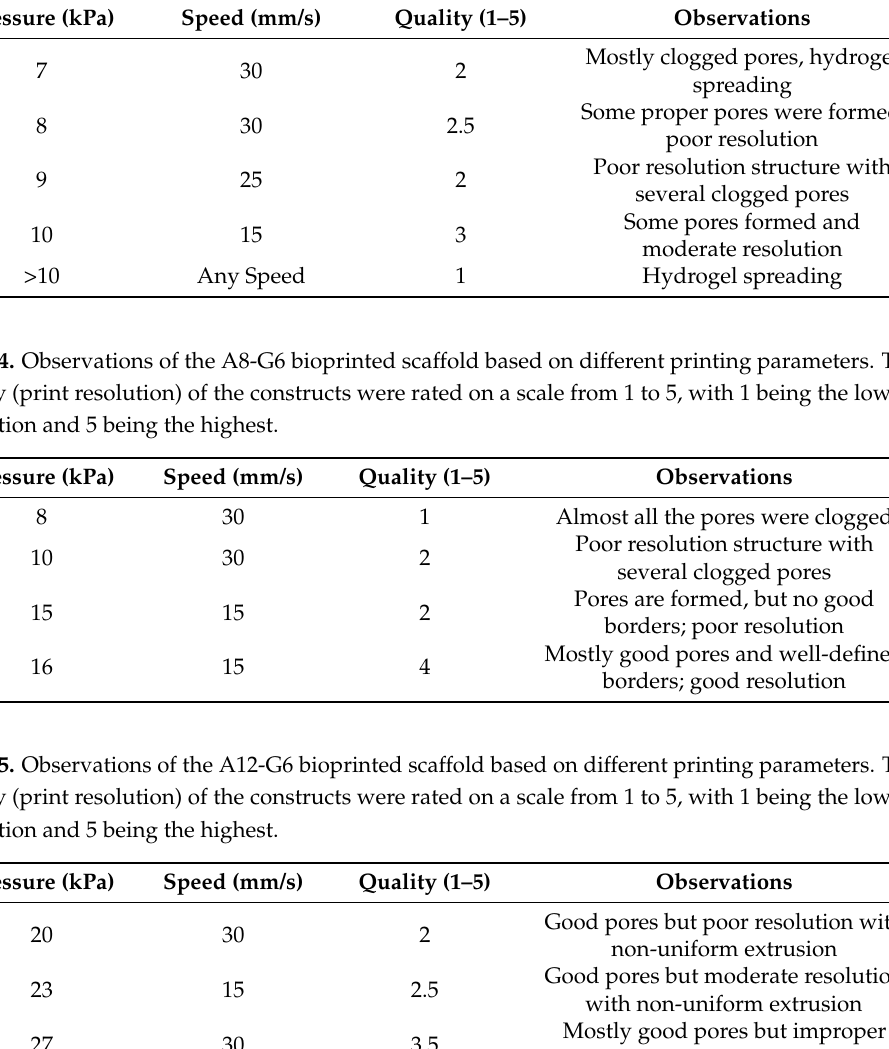
Table 3. Observations of the A6-G6 bioprinted scaffold based on different printing parameters. The quality (print resolution) of the constructs were rated on a scale from 1 to 5, with 1 being the lowest resolution and 5 being the highest.